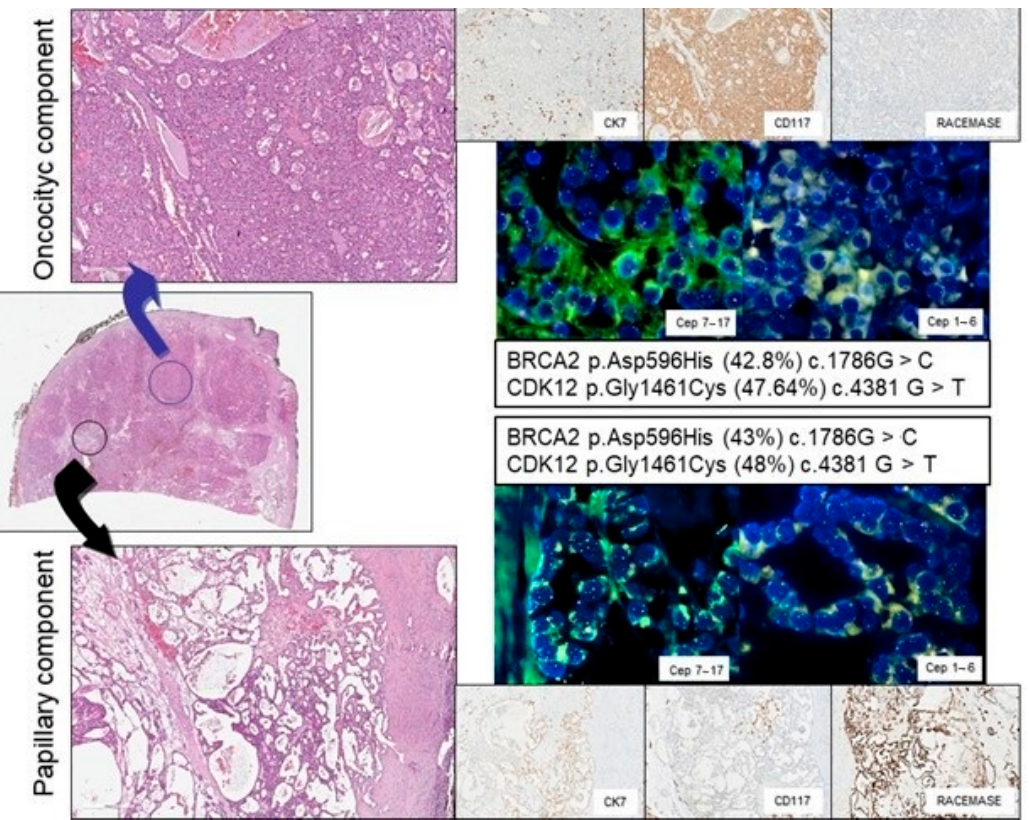
Figure 1. Representative histological, immunohistochemical, fluorescence in situ hybridization (FISH), and genetic analysis of a renal tumor with oncocytic (top panels) and papillary (bottom panels) features:magnification for hematoxylin and eosin, 10× and 20×; for immunohistochemistry, 20×; and for FISH, 100×. The FISH analysis demonstrated in 3/10 cases a gain of chromosome 7/17 in the pa- pillary component, as expected in a papillary renal tumor. Concomitant deletion of Table 2. Histological, immunophenotypic, and genetic features of the 11 cases: IHC (immunohistochemistry), FISH (fluorescent in situ hybridization), and HOT (hybrid oncocytic